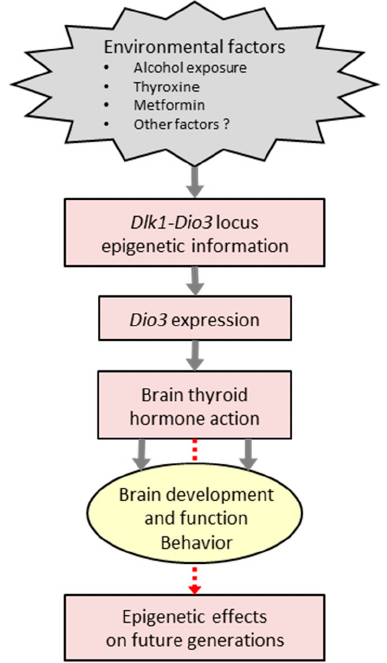
Figure 4. Environmental factors and Dio3 imprinting. Environmental factors may influence Dio3 imprinting and expression, with consequences for TH action in the brain in affected (grey arrows) and future generations (dotted red arrow).